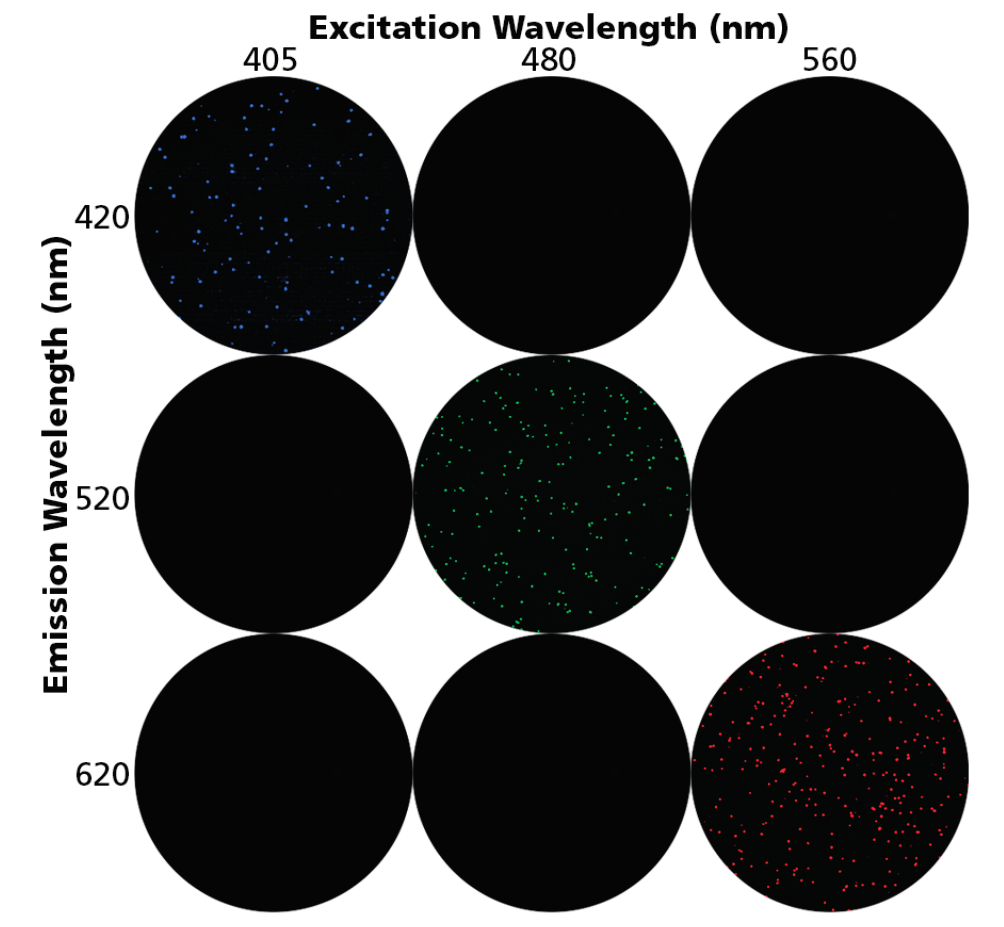
Figure 1. Unambiguous detection of Peripheral Blood Mononuclear Cells (PBMC) positive for Acridine Orange, Propidium Iodide, and Po-Pro-1. PBMC were stained with either Acridine Orange, Propidium Iodide, or Po-Pro-1™ and were imaged at the specified excitation and emission wavelengths. AO-stained (live) cells are detected at 480/520 nm only, PI-stained (dead) cells at (560/620 nm) only, Po-Pro-1 stained (apoptotic) cells at 405/420 nm only. No cross bleeding of signal between the dyes is detectable, providing unambiguous detection of each cell